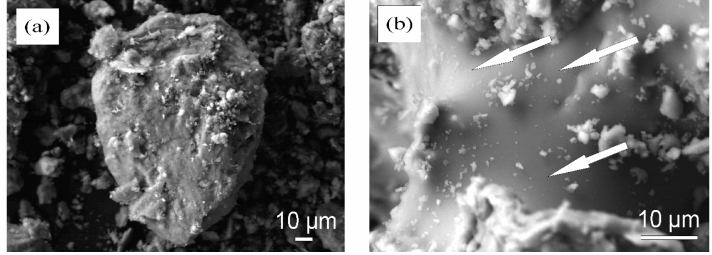
Figure 3. SEM image of ( a ) non-fired OCW and ( b ) OCW after firing at 1060 ◦ C.